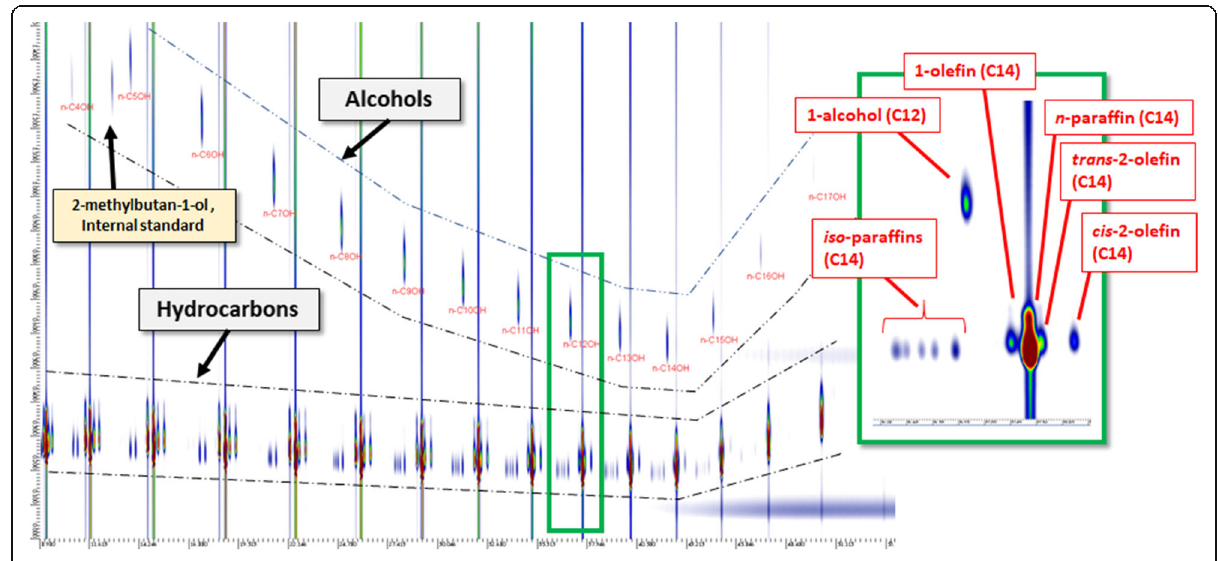
Fig. 5 GCxGC analysis of LHcL1